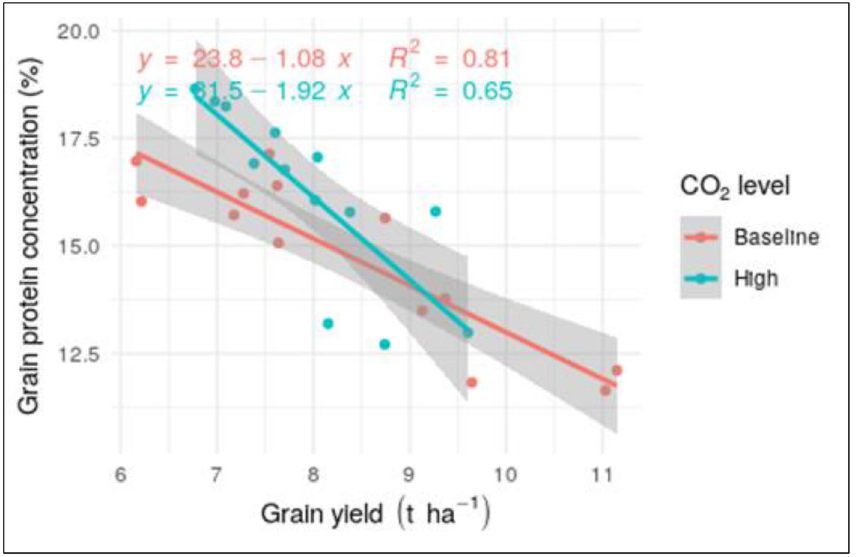
Figure 4. Relationship between grain yield and protein content for spring wheat varieties KWS Bittern, Lennox and Lantvete grown under baseline CO 2 (400 ppm; red points) and high CO 2 level (700 ppm; blue points). Solid red and blue lines are linear regressions fitted against the red and blue points respectively and grey areas are 95% confidence intervals.